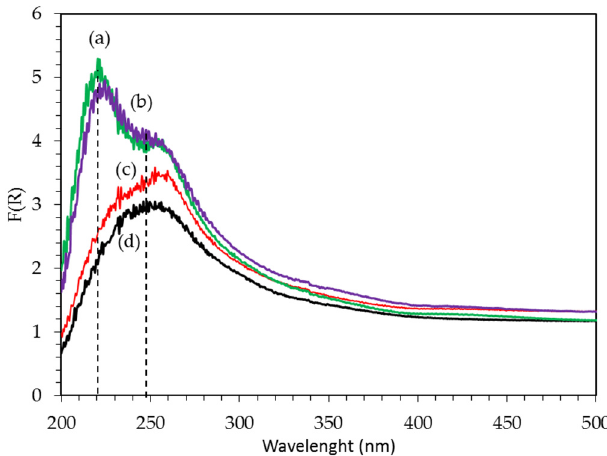
Figure 6. Ex situ UV–Vis spectra of the PtAg / AW catalysts calcined at 500 ◦ C when the Pt concentration changed from 0.1 to 1 wt% on Al 2 O 3 –WOx catalysts. ( a ) 1PtAg / AW; ( b ) 0.4PtAg / AW; ( c ) 0.25PtAg / AW; and ( d ) 0.1PtAg / AW.